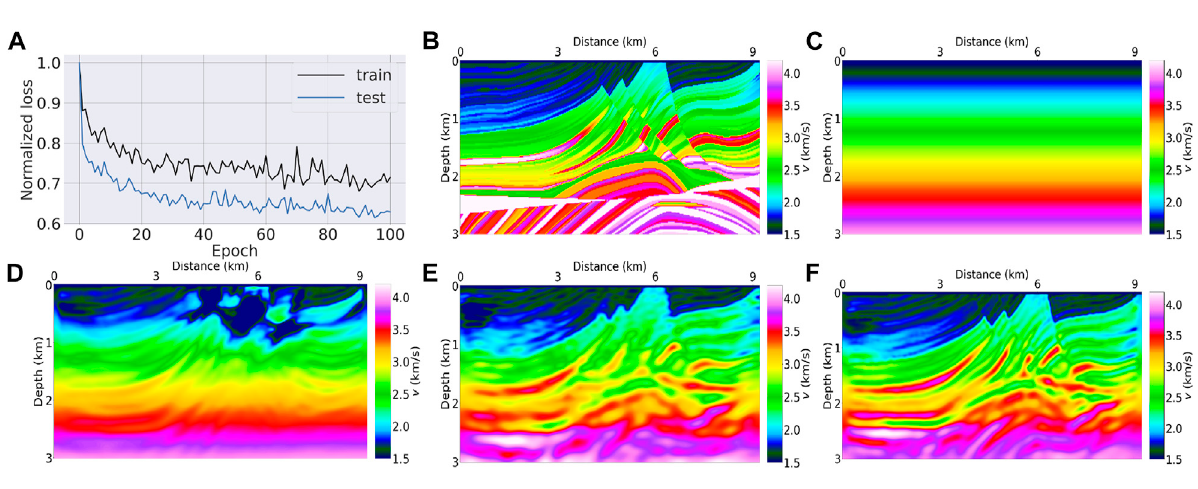
FIGURE 11 Application of the ML-mis fi t to the Marmousi model: (A) the loss over epochs for training the ML-mis fi t on the randomly generated 2D model; (B) thetrue Marmousimodel; (C) the initial model for starting theinversion; (D) inversionresult for theL2norm; (E) inversionresult for theML-mis fi t; (F) inversion result for the L2 norm using (E) as the starting